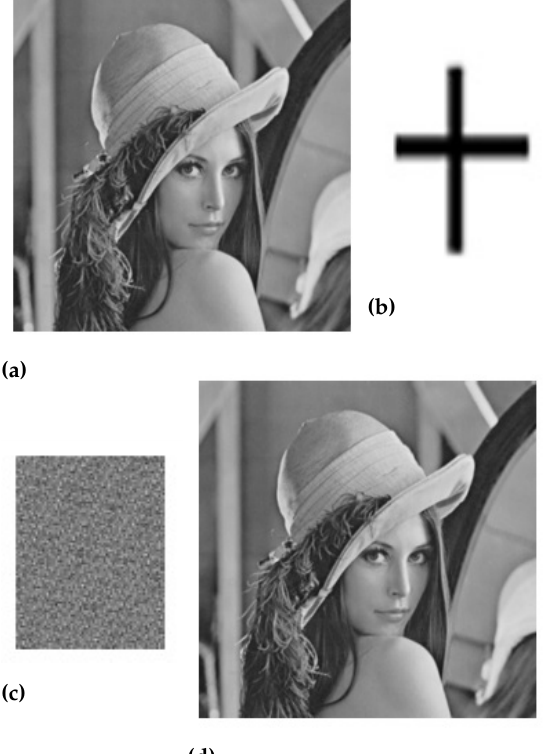
Figure 5. ( a ) Original Lena image, ( b ) Watermark image, ( c ) Scrambled image, and ( d ) Watermarked Lena image.